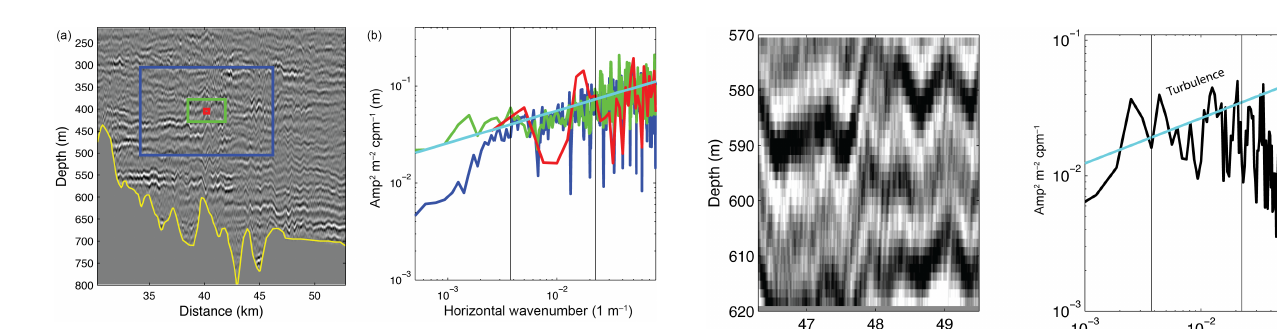
Figure 5. (a) Line Limon1 with three analysis boxes of varying size that correspond to normalized seismic slope spectra of the same color in (b) . The three analysis regions match the characteristic turbulence slope of the Batchelor spectrum (cyan line) over our prescribed wavenumber range marked by gray vertical lines. The smallest, red box is our analysis window and resolution for turbu- lence mapping via data transform and sized 400m by 10m. The largest, blue box has the best statistics and fit to the characteristic slope and is 12000m by 200m in size. This large, blue box was chosen to mimic the analysis of Sheen et al. (2009), who presented the first turbulence estimates from seismic data using tracked re- flectors. Such a method would be inadequate to examine relatively small features, such as lee waves. The middle, green box is shown to demonstrate the match of seismic slope spectra to the characteristic slope at the scale of our tracked reflector analysis.